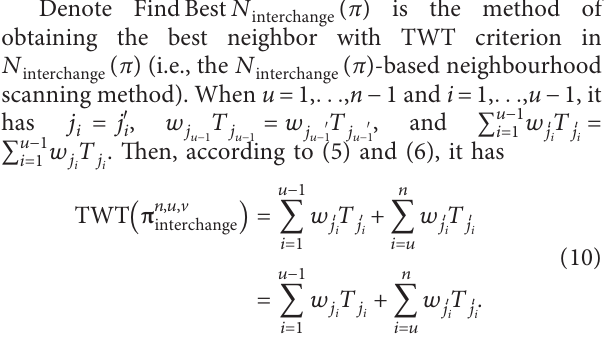
Figure 3: A small example of π n,u,v v � 7. L